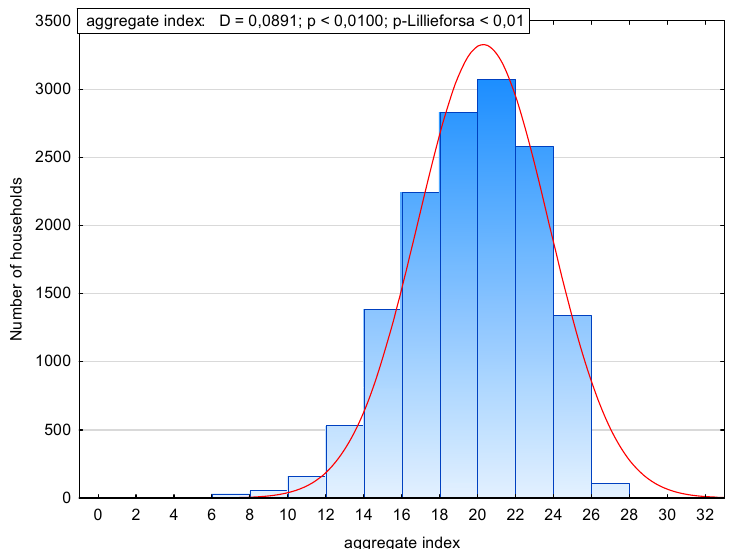
Figure 2. Distribution of the aggregate indicator for households of people aged 60 and older in 2018. Source: own elaboration based on data from [136].